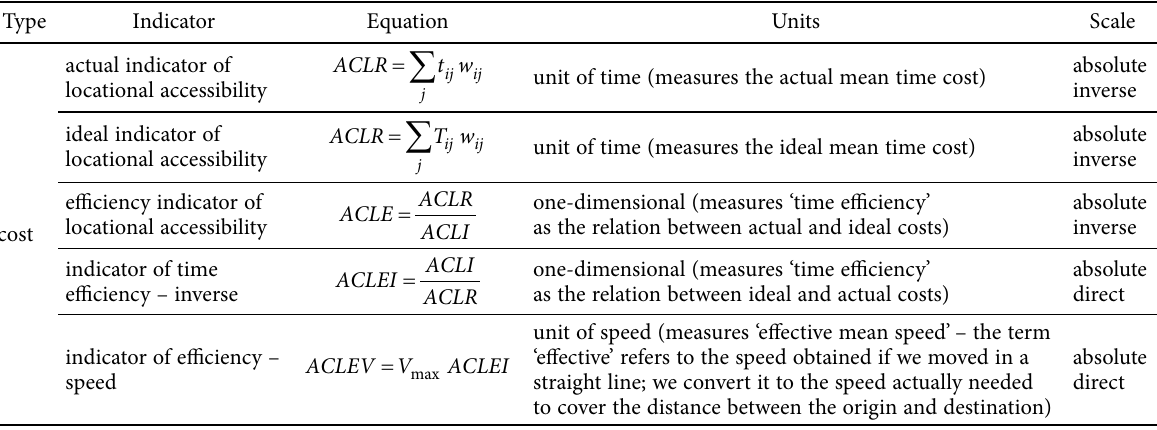
Table 2. Cost accessibility indicators